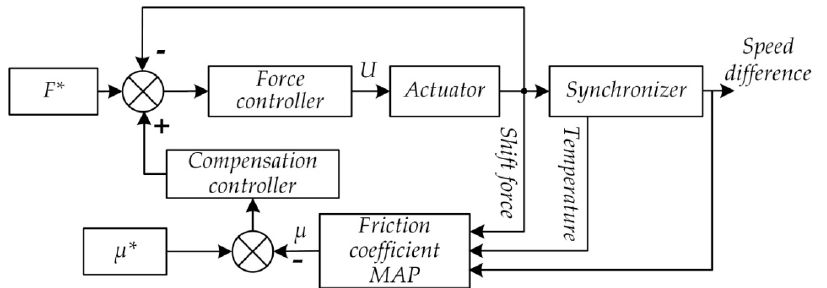
Figure 8. Principle of compensation control.